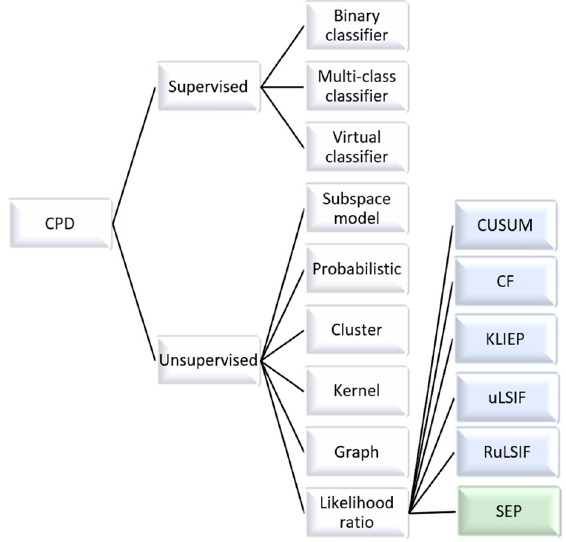
Figure 6. Recent approaches to change point detection.